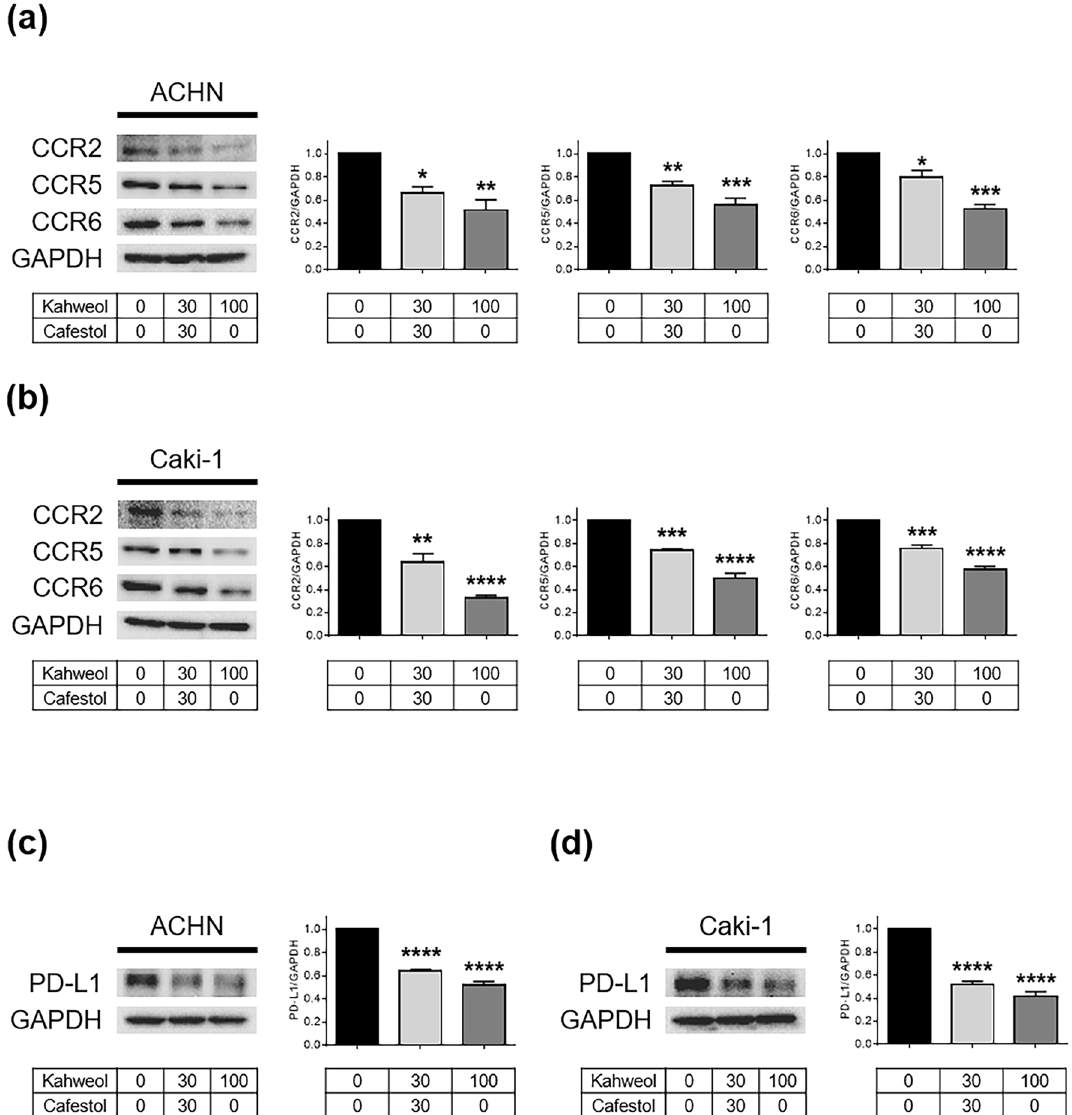
Caki-1 ( b ) cells, and programmed death-ligand 1 (PD-L1) in ACHN ( c ) and Caki-1 ( d ) cells treated for 24 h were measured using Western blot analysis and quantitatively analyzed using densitometry with ImageJ software as shown by bar graphs. The soluble cell lysates (10 µg in CCR2/5 and PD-L1, 20 µg in CCR6) were subjected to electrophoresis. Data were presented as means ± standard error of the mean (n = 3). * p < 0.05; ** p < 0.01; *** p < 0.001; **** p <